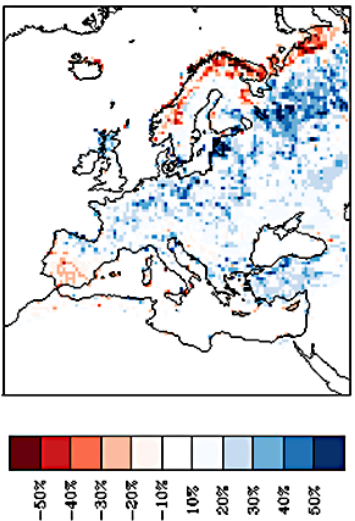
Figure 7. Differences in forest cover between REMO-iMOVE and